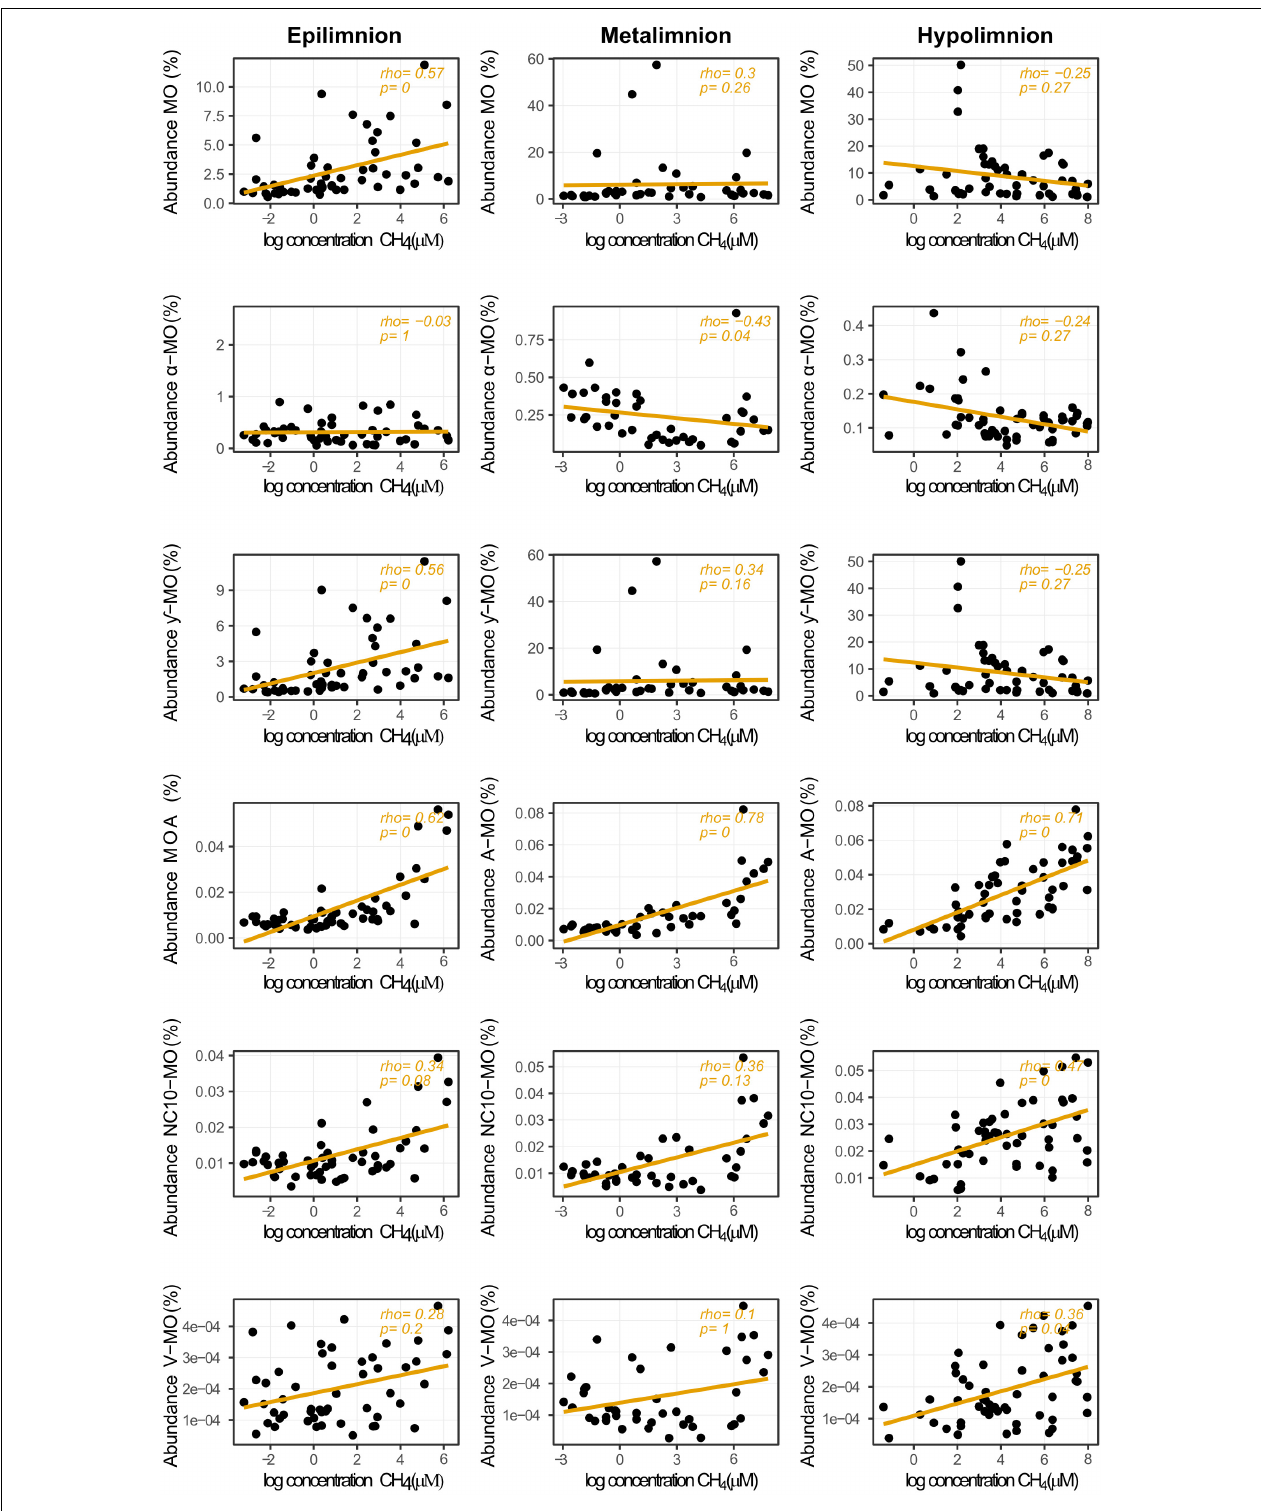
FIGURE 6 | Relationship between relative abundances of methane oxidizers and CH 4 concentrations in the different layers of stratified lakes. The taxa represented are alphaproteobacterial methanotrophs ( α -MO), gammaproteobacterial methanotrophs ( ), Archaea (MOA), bacterial phylum NC10 (NC10-MO), Verrucomicrobial methanotrophs (V-MO), and the sum of all methane oxidizers (MO). Rho indicates Spearman’s rank correlation coefficients. p -values were adjusted with the Bonferroni method and rounded to two digits. Null p -values indicate p ≤ 0.005.